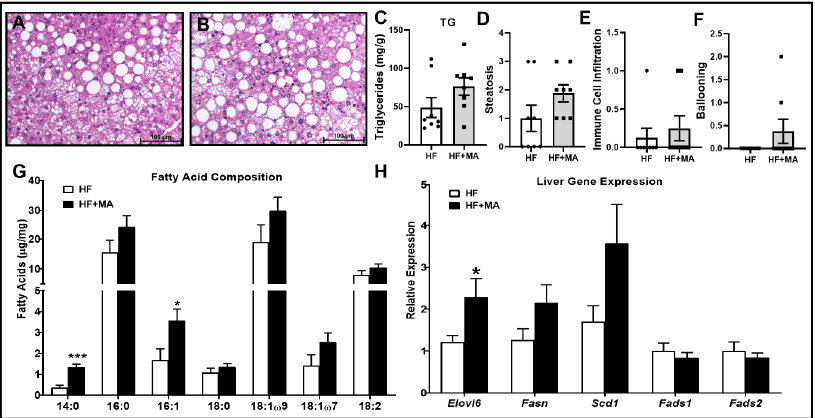
Figure 7. Effect of dietary myristic acid on hepatic steatosis. Liver sections from HF ( A ) and HF+MA ( B ), were stained with hematoxylin and eosin. Images were captured at 20 × magnification using a Nikon Eclipse 80i microscope. Liver triglycerides ( C ) were measured by gas chromatography. Histology scores for the extent of steatosis ( D ), immune cell infiltration I( E ), and ballooning ( F ) are shown. Fatty acid composition of liver TG is shown ( G ). Real-time PCR analysis was performed for the mRNA levels of genes involved in fatty acid synthesis, elongation, and desaturation ( H ). Values are expressed as mean ± SEM of 8 samples in each group. * p < 0.05 and *** p < 0.001 vs. HF. HF, high fat; HF+MA, high fat + myristic acid; 14:0, myristic acid; 16:0, palmitic acid; 16:1, palmitoleic acid;